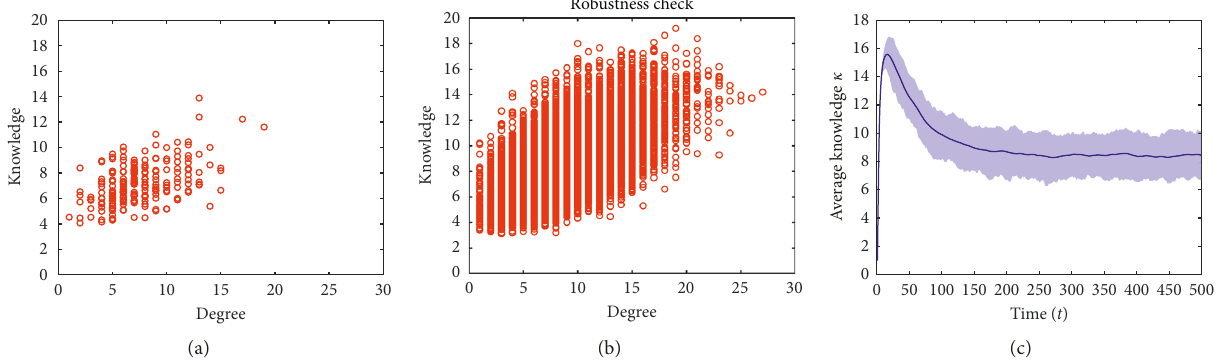
Figure 4: Evolution result when the initial R&D network structure is a random graph ( p � 0 . 2).